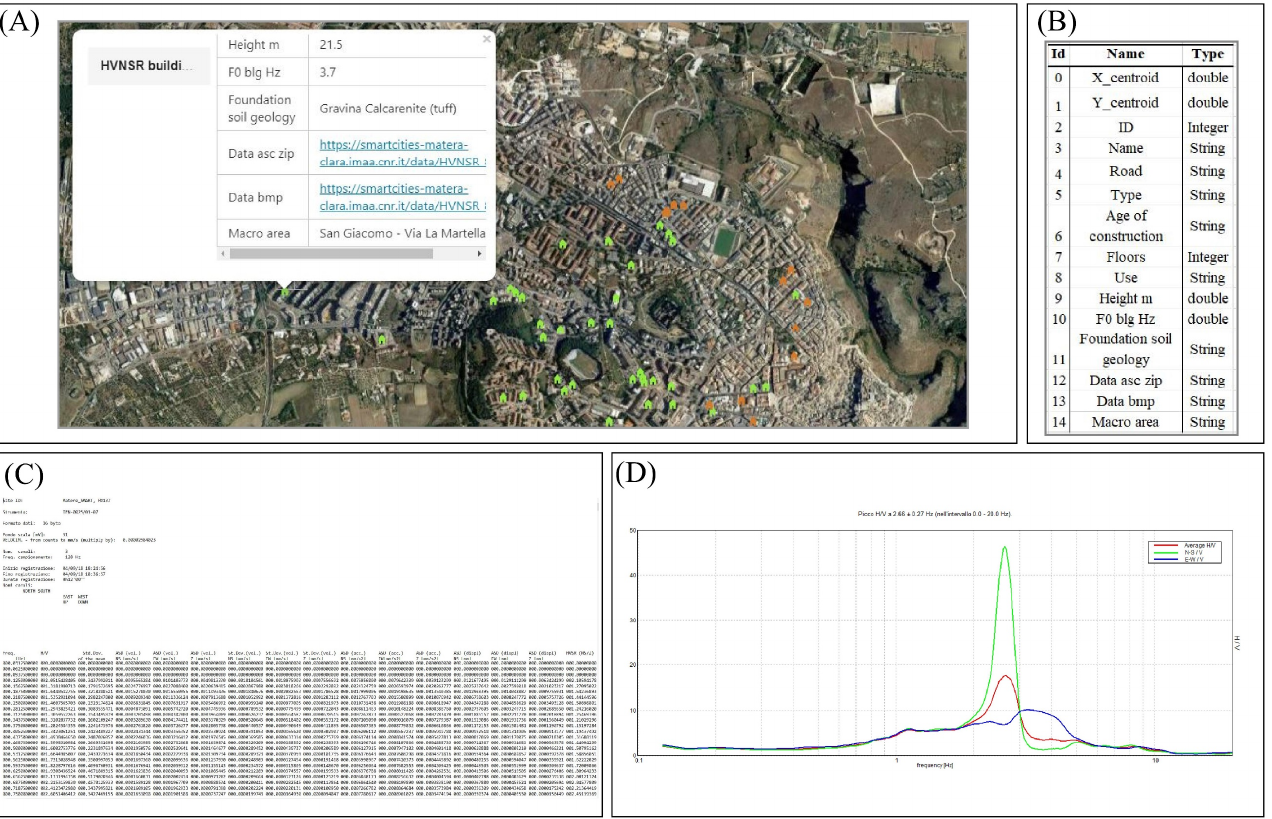
Figure 7. ( A ) Pop-up window showing the factsheet of a sample measurement (HVNSR_69) made on a R.C. building;